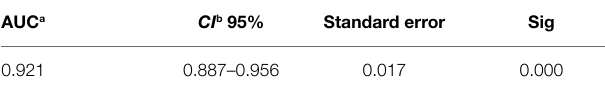
TABLE 5 | T -test analysis by gender of teachers. TABLE 6 | ROC curve parameters (female gender).